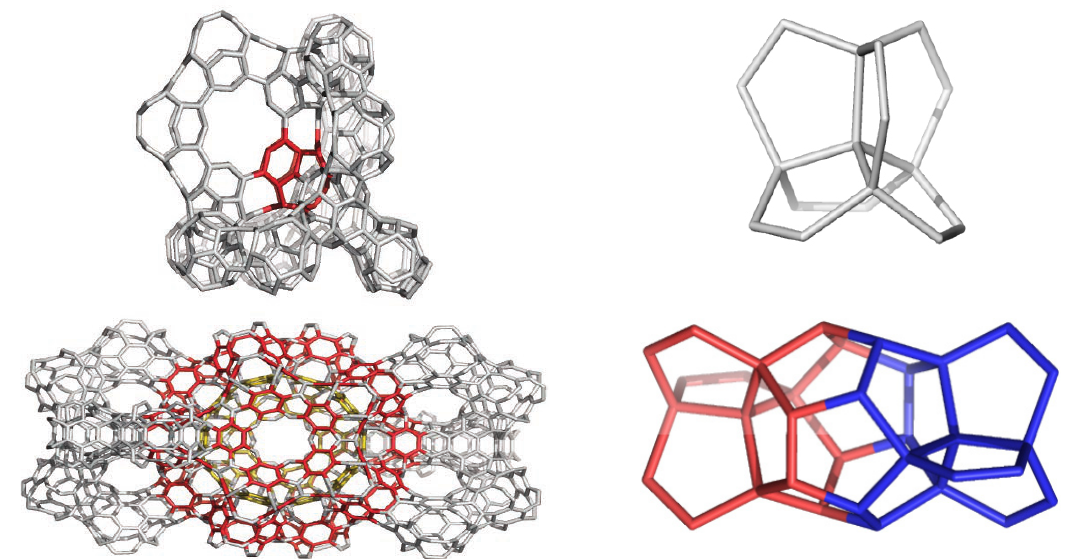
Figure 3. Top row: BTZ17_408 (left) and C